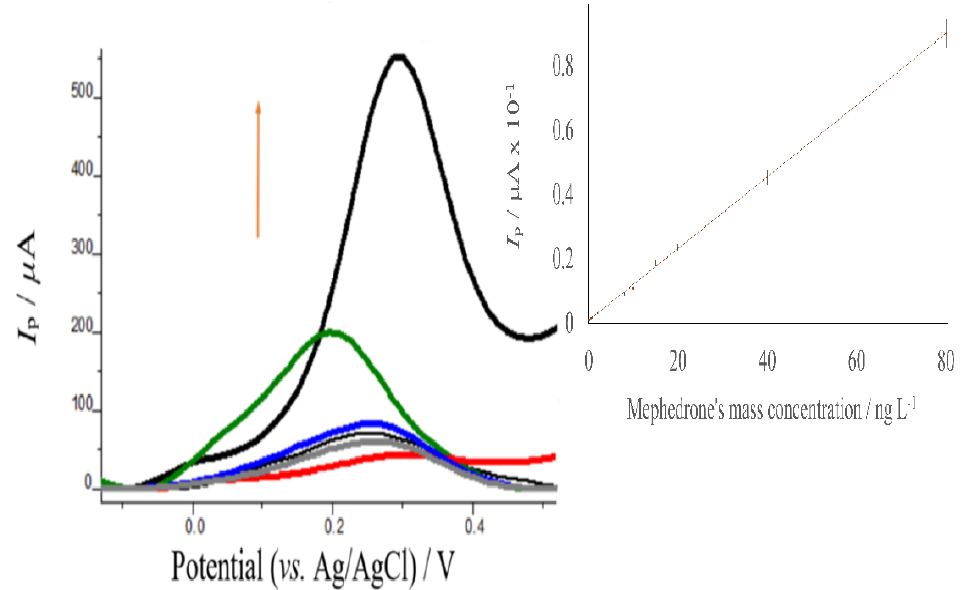
Figure 7. Anodic square wave voltammograms of poly-AgNPs@Sa-CPE under the optimized conditions for mass concentration of mephedrone between 1.841 ng L − 1 to 80.00 ng L − 1 (red color: 1.841 ng L − 1 , grey: 3.000 ng L − 1 , black: 5.000 ng L − 1 , blue: 10.00 ng L − 1 , green: 20.00 ng L − 1 , bold black: 80.00 ng L − 1 ). Inset: mephedrone’s calibration curve from 1.841 ng L − 1 to 80.00 ng L − 1 . Conditions: